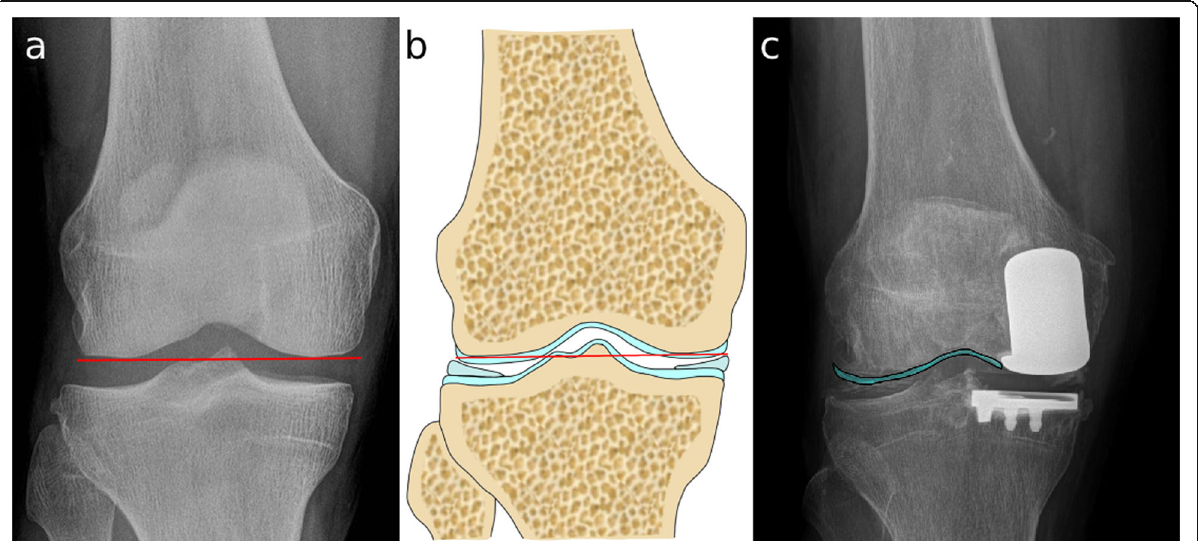
Fig. 2 Joint line and cartilage ( a ) Radiological joint line measured in a native knee. b Shows the radiological joint line in the subchondral bone. The femoral cartilage is 2 mm thick. c Implant positioned in reference to the cartilage and not the subchondral bone